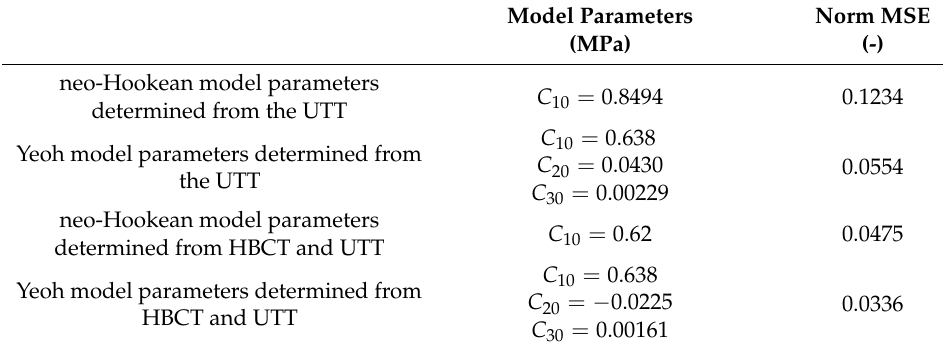
Table 4. Determined material parameters of constitutive models of elastomer.